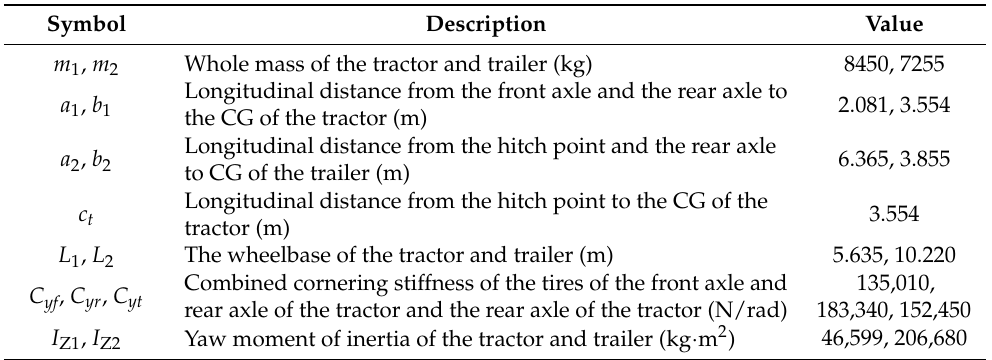
Table 1. Vehicle dynamics